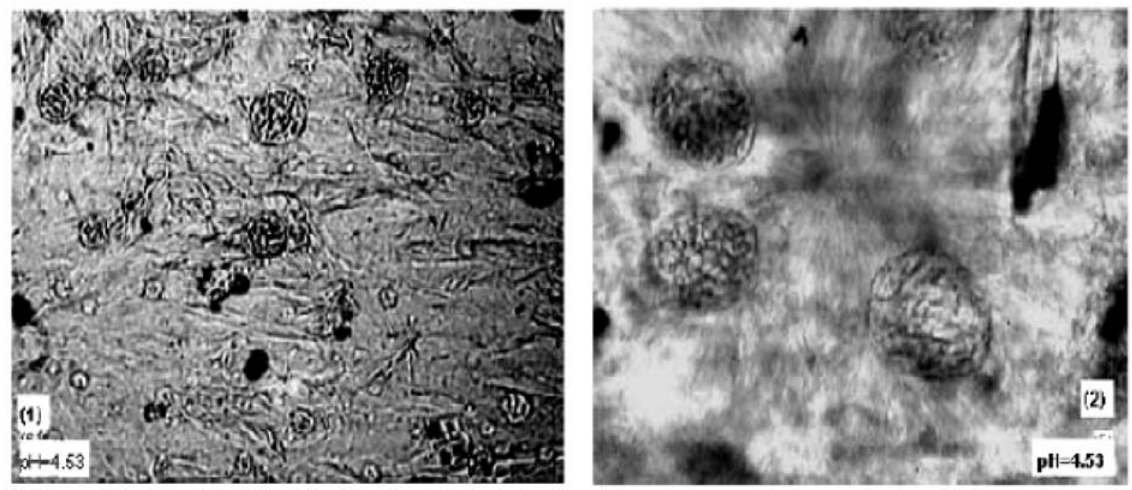
Fig. 10 Microscopic images of solid PEG-rich phase in the absence of H 2 SO 4 , pH=4.53, after metal species extraction (Cd i = 57.05 µ g/mL, [I − ] ad = 0.06 mol/L: (1) detail at 600x, (2) detail at 700x).